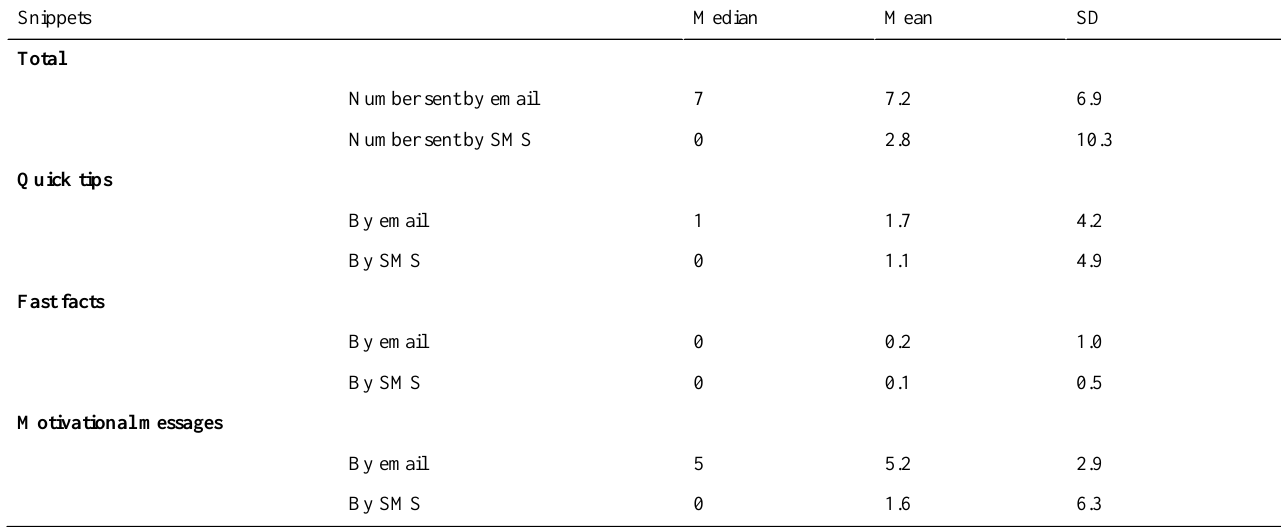
Table 3. Snippets usage statistics